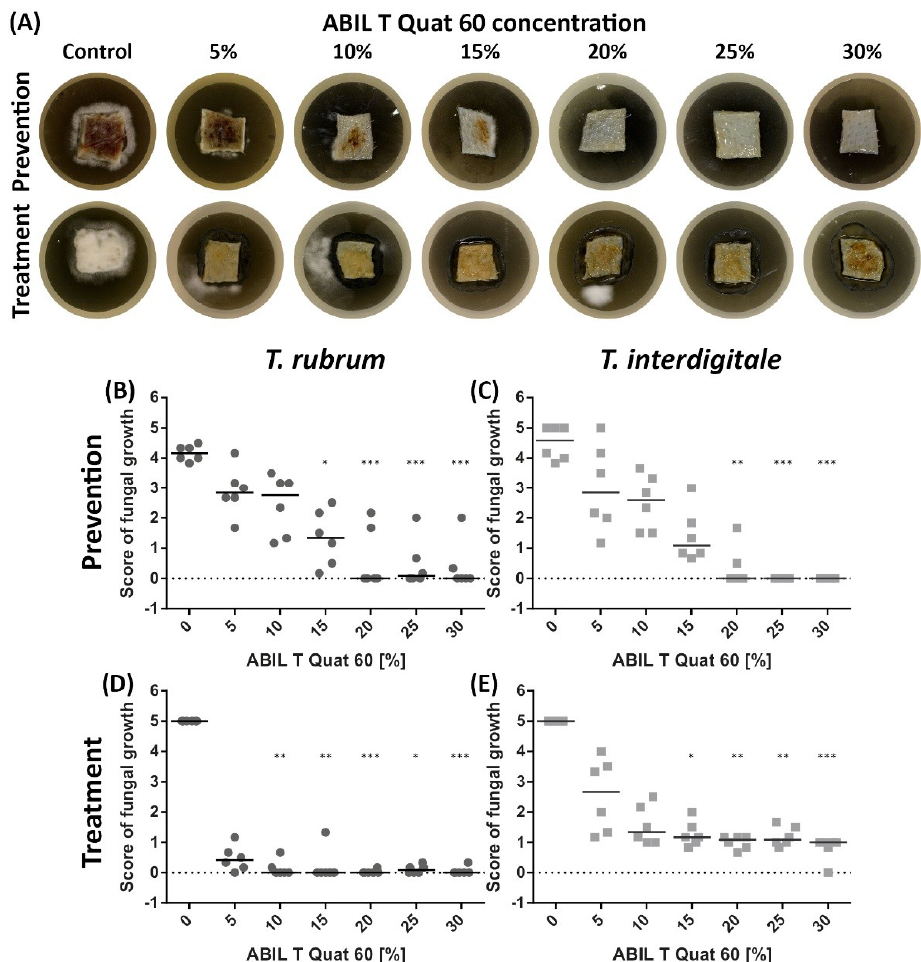
Figure 1. Effect of ABIL (5–30%) on the ex vivo fungal growth of T. rubrum and T. interdigitale in prevention and treatment experiments. ( A ) Representative images of fungal growth on porcine skin to which ABIL was applied before inoculation with T. rubrum (prevention) or treated with ABIL 3 days after inoculation with T. rubrum (treatment). Panels ( B – E ) show the median scores values for fungal growth (Table 1): ( B ): Prevention of T. rubrum growth; ( C ): Prevention of T. interdigitale growth; ( D ): Treatment of T. rubrum infected skin; ( E ): treatment of T. interdigitale infected skin. Statistical analysis was performed using a Kruskal-Wallis ANOVA followed by Dunn’s post hoc test: n = 6/group: * p < 0.05, ** p < 0.01, *** p < 0.001 vs. control.